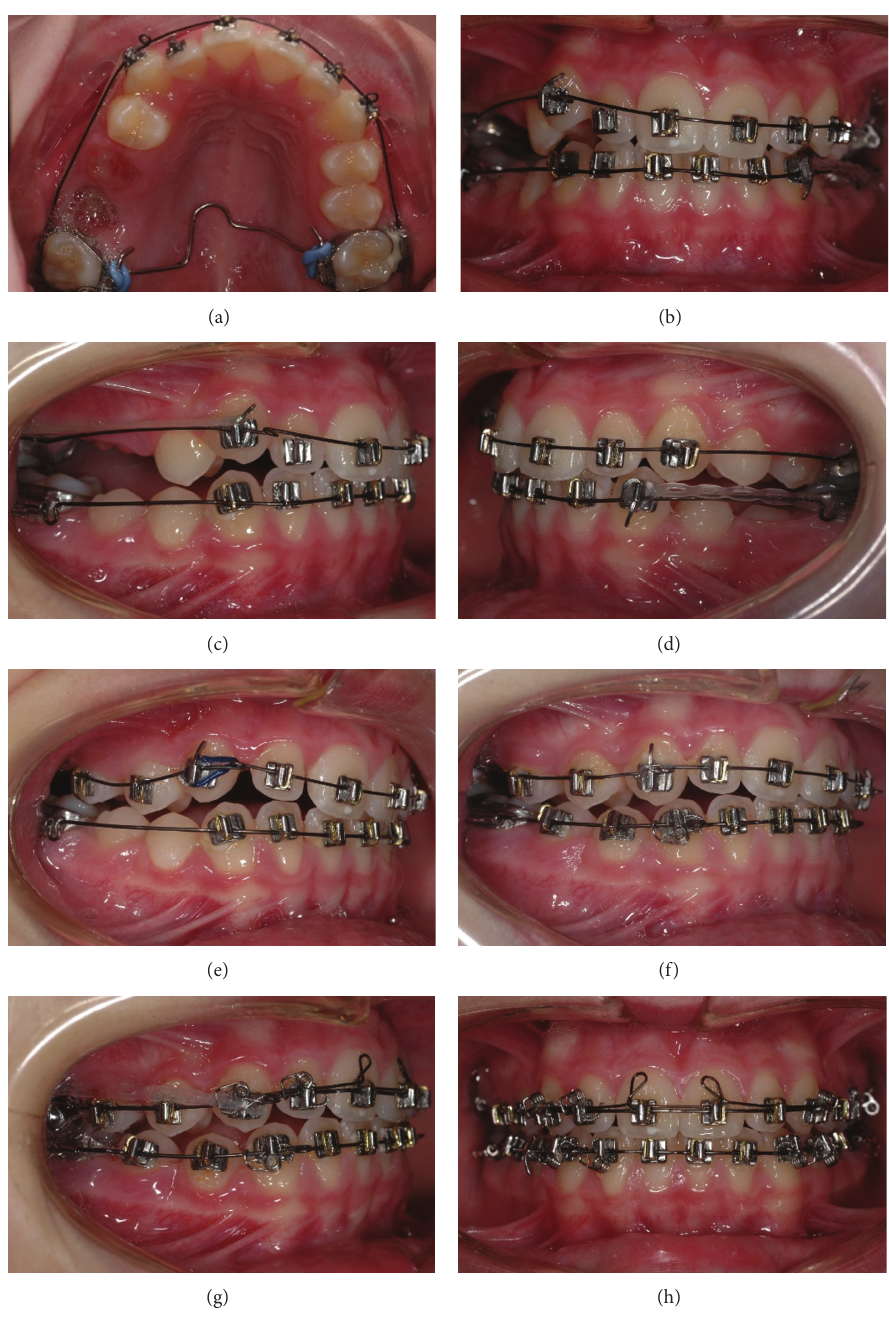
Figure 4: (a–d) Class II correction on the right side using TPA anchorage and horizontal elastics. In this phase, premolars were not bonded to facilitate sliding mechanics. (e-f) After achieving Class I premolar relationship, the remaining teeth were bonded. (g) Space closure with elastic power chain. (g, h) Torque correction by means of a customized two-spur torque auxiliary of 0.014-inch regular wire and uprighting springs on the maxillary canine